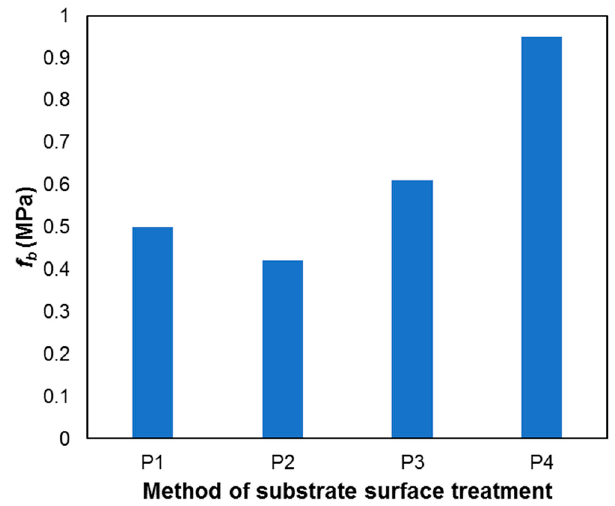
Figure 14. Relation of the pull-off adhesion f b between the overlay and the substrate with regards to the method of treatment of the surface (based on the results presented in Reference [44]). Key: P1— patch grabbed (raw) surface, P2—formed after contact with the surface of formwork (as cast); treatment with removing cement laitance: P3—mechanically grinded surface,